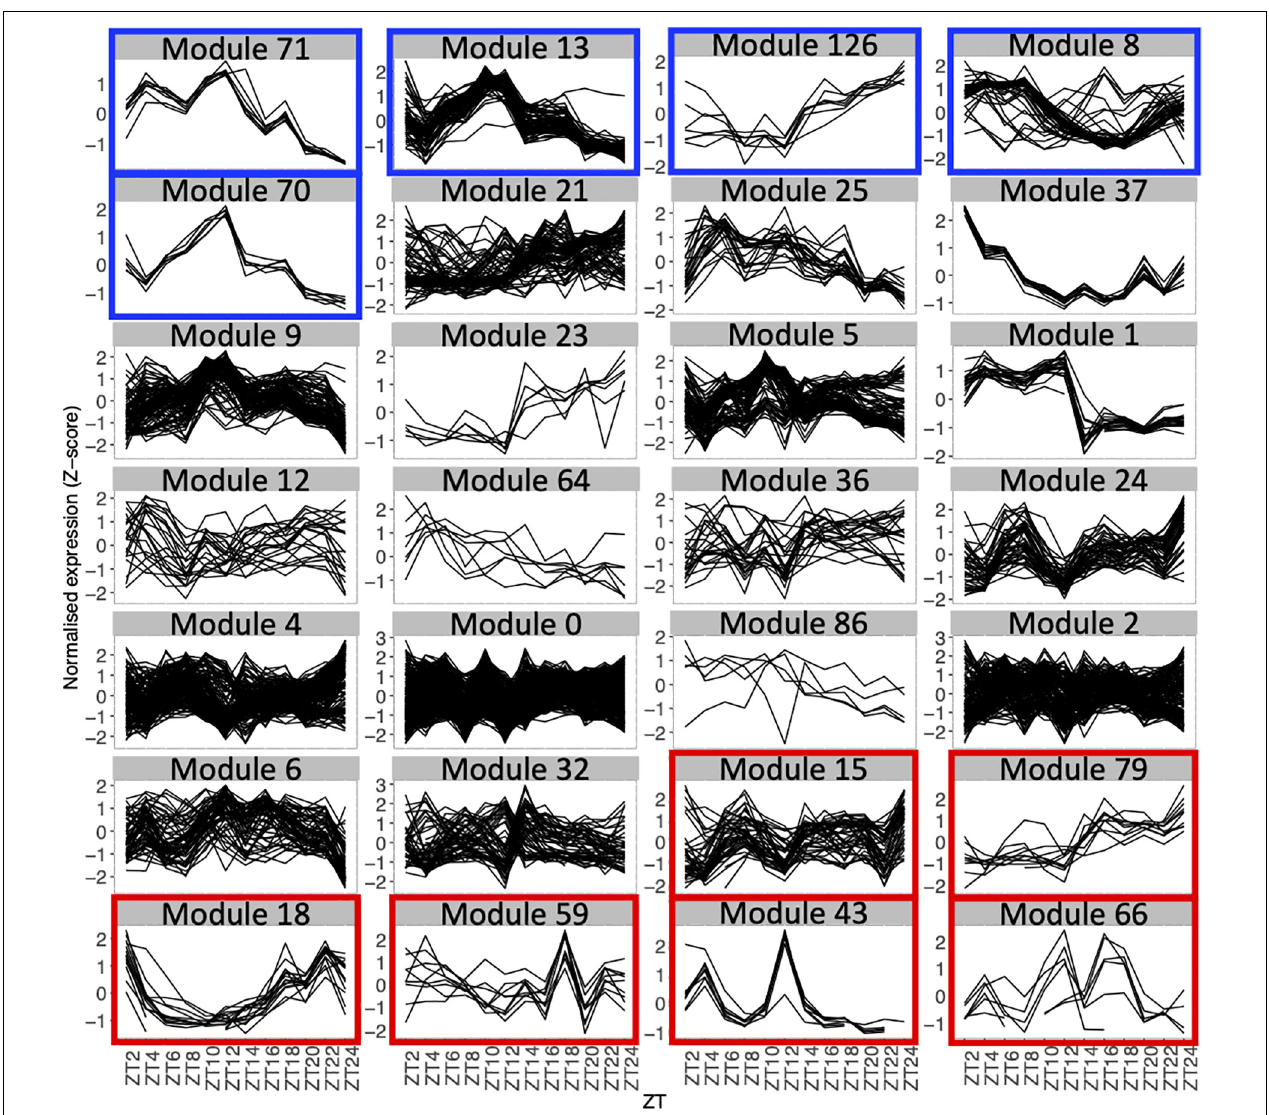
FIGURE 2 | Expression profiles throughout the time course for genes in each module with 5 genes or more, using the average expression of the fourteen seedlings for each time point. Each line represents the normalized expression (z-score) for one gene. Modules are ordered by the percentage of genes in the averaged time course network (high to low). Modules highlighted in blue contain 50% or more of genes that are also in the averaged time course network. Modules highlighted in red contain 15% or less of genes that are also in the averaged time course